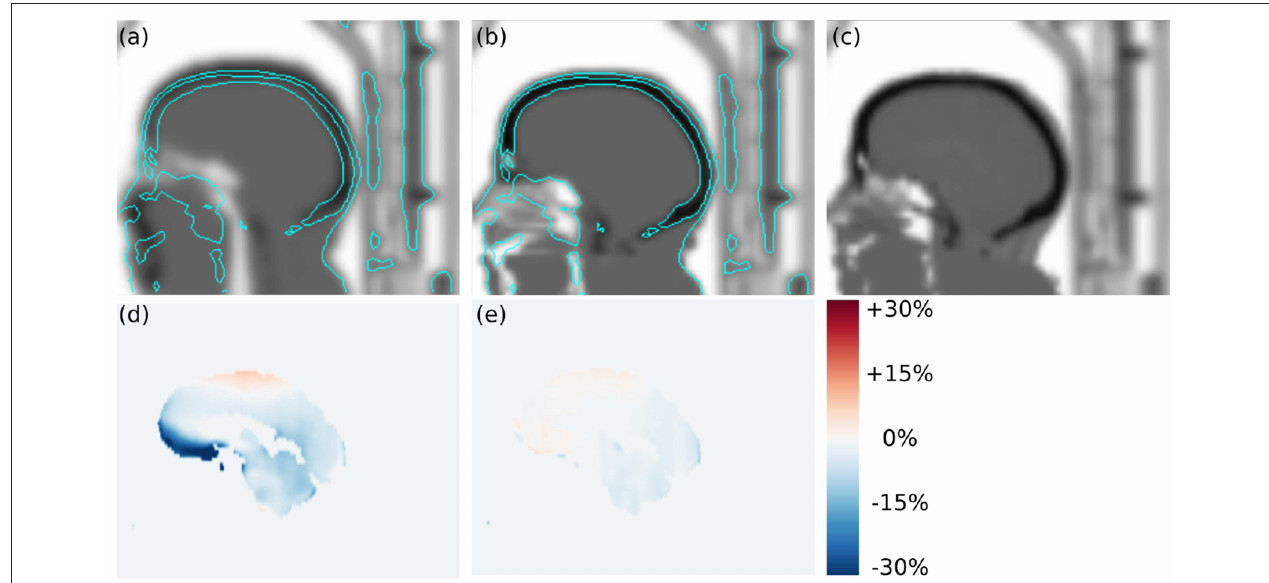
FIGURE 5 | Transversal slices of (a) atlas-based attenuation image, (b) ZTE-based attenuation image, (c) CT-based attenuation image, (d) regional bias in PET AtlasAC , and (e) regional bias in PET ZTEAC of subject 24. In this case, the template registration in the atlas-based attenuation image failed which caused a misclassification of soft tissue voxels as air voxels in the frontal region. The cyan contour lines show the head contour in the CT-based attenuation image for comparison. As a result of the underestimated attenuation PET AtlasAC shows strong negative bias of up to − 32% in the left straight